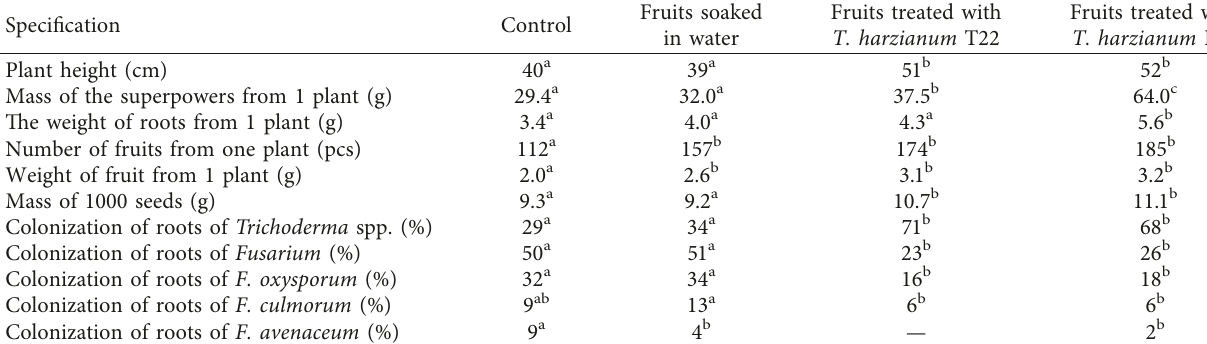
Table 3: Coriander’s biometrics and roots